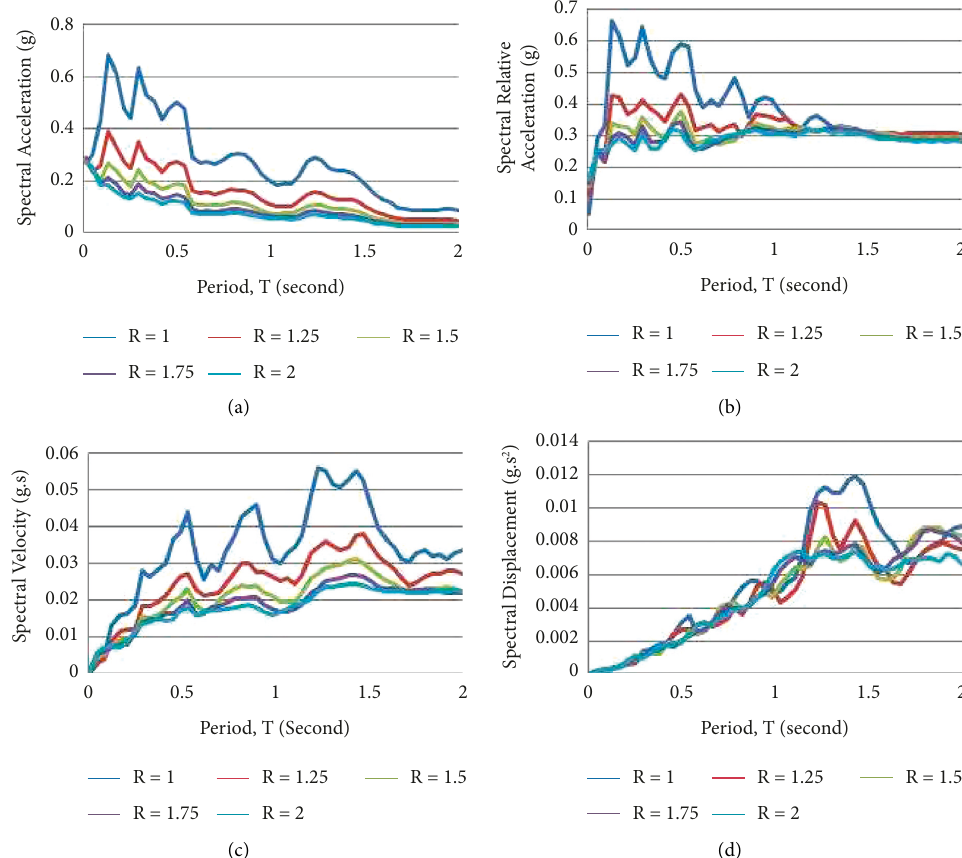
Figure 9: Earthquake with an epicenter at Kayseri-Kocasinan ( M D : 3.7) and the record of north-south (N-S) route. (a) Scaled spectral total acceleration, (b) spectral relative acceleration, (c) spectral velocity, and (d) spectral displacement spectrum